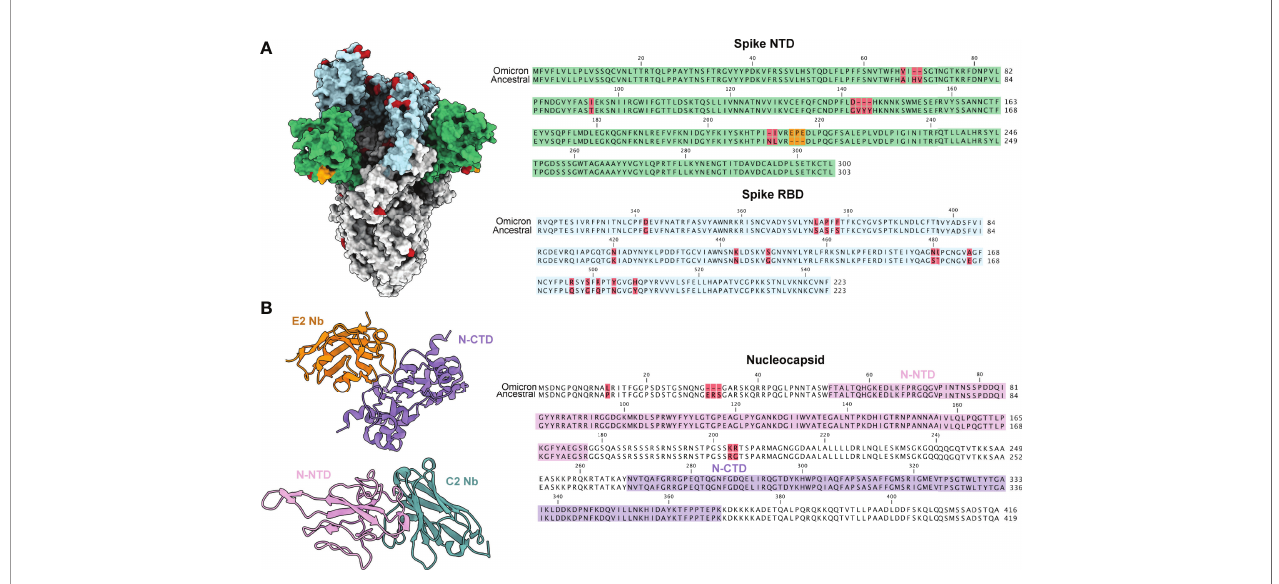
FIGURE 1 | SARS-CoV-2 variant mutations are predominately localized to the spike glycoprotein. (A) A model of the ancestral SARS-CoV-2 spike glycoprotein (PDB 6VXX) with NTD coloured in green and RBD coloured in light blue. Mutations present in the omicron variant (7QO7) are highlighted in red and insertion in orange. Sequence alignments of NTD and RBD are shown to the right with the same coloring scheme. (B) Structures of E2 (orange, PDB 7N0I) and C2 (turquoise, PDB 7N0R) nanobodies complexed with either the CTD (purple) and NTD (pink) of the nucleocapsid protein. The NTD and CTD of N are coloured in a sequence alignment to the right with mutations present in omicron coloured in